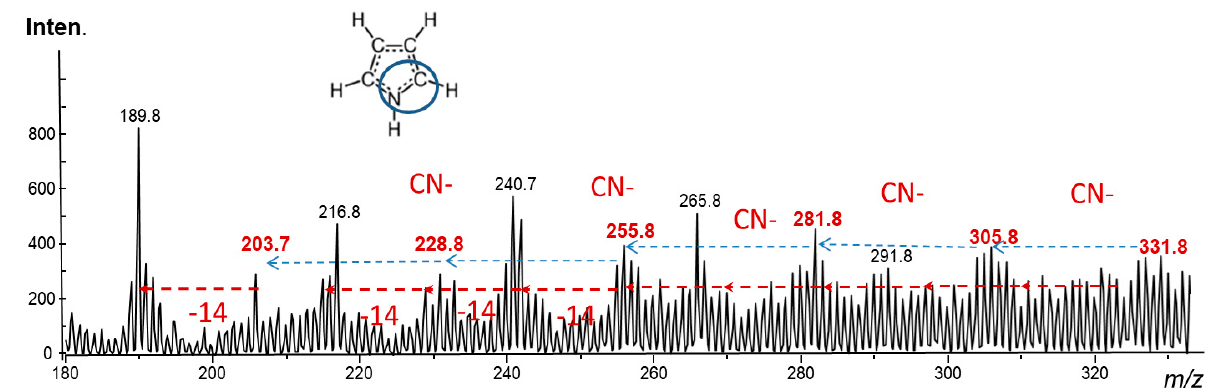
Figure 5. Laser desorption ionization mass spectrometry (LDI-MS) spectra recorded from CuI-PPy deposited by drop coating on the surface of SPE modified by graphene oxide (SPE/GO), laser fluence 40%. Note: LDI–MS analysis was performed at the atmospheric pressure conditions (AP-MALDI ion source); all experiments were performed in a triplicate with the same results. Signal to noise ratio (SNR) determined for CN - species at the used experimental conditions was in the range from 10:1 to